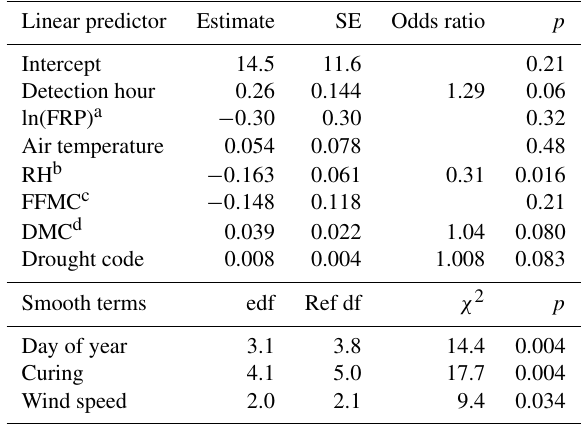
Table 2. The linear predictors of the GAM predicting whether a hotspot cluster is a wildfire (coefficients given in logit space) along- side their odds for predictors with p< 0 . 10. Smoothing of the GAM is shown with χ 2